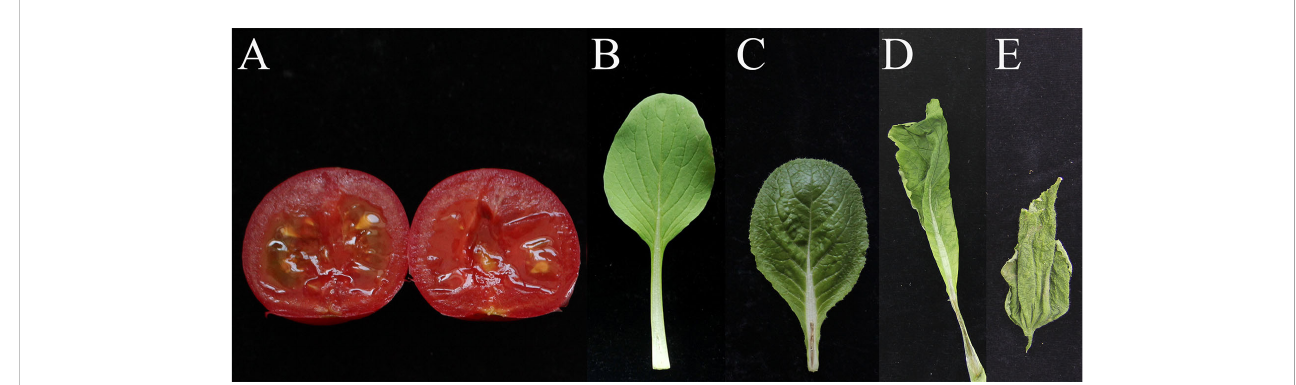
FIGURE 6 P . polonicum isolate BY21311 host range determined. The stems of vegetables were detached and photographed 7days after in fi ltration. Washed and surface sterilized tomato were inoculated with isolate BY21311 and cut open at 3 days after inoculation. (A) tomatoes ( Solanum lycopersicum L.) (B) Brassica chinensis L. (C) baby chinese cabbage, (D) baby bok choy ( Brassica campestris L.ssp .chinensis Makino var. communis Tsen et Lee), (E) Cucumis sativus